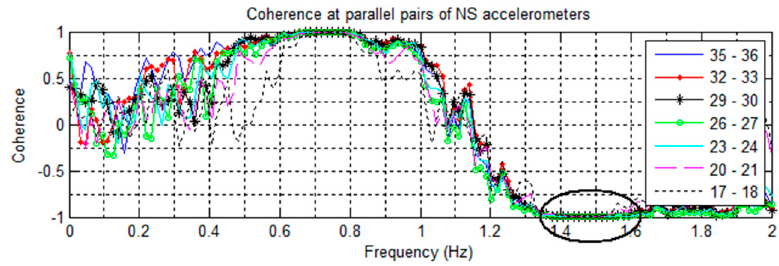
Figure 7. Coherences of parallel pairs of NS oriented accelerometers from the 6/22 ambient vibration recording. The negative coherence at 1.47 Hz indicates a torsional mode.